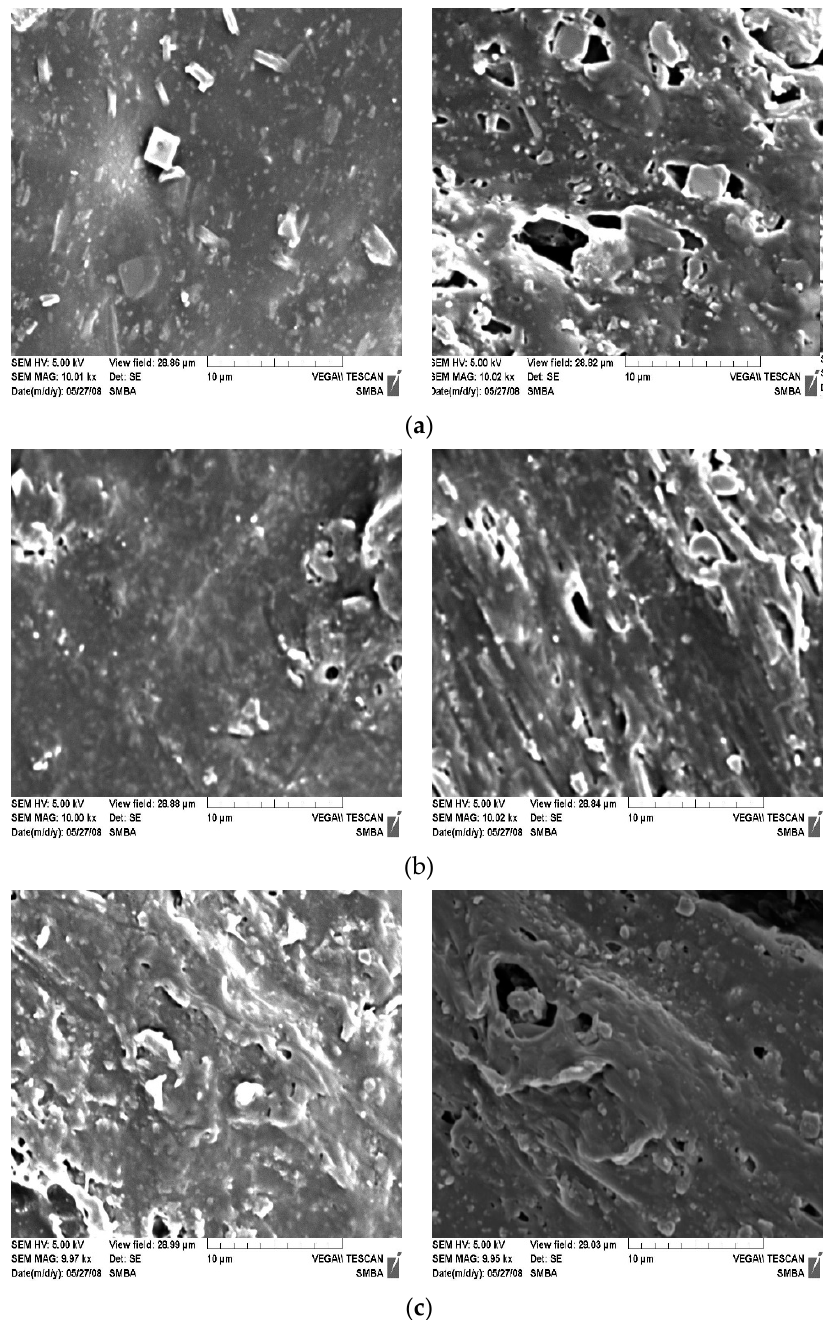
Figure 7. Comparison of SEM photos before and after tensile test of specimen surface (top), injection specimen (right), and surface immediately after tensile test: ( a ) Mg(OH) 2 without treatment; ( b ) Mg(OH) 2 with CA treatment; ( c ) Mg(OH) 2 with excessive amount of CA